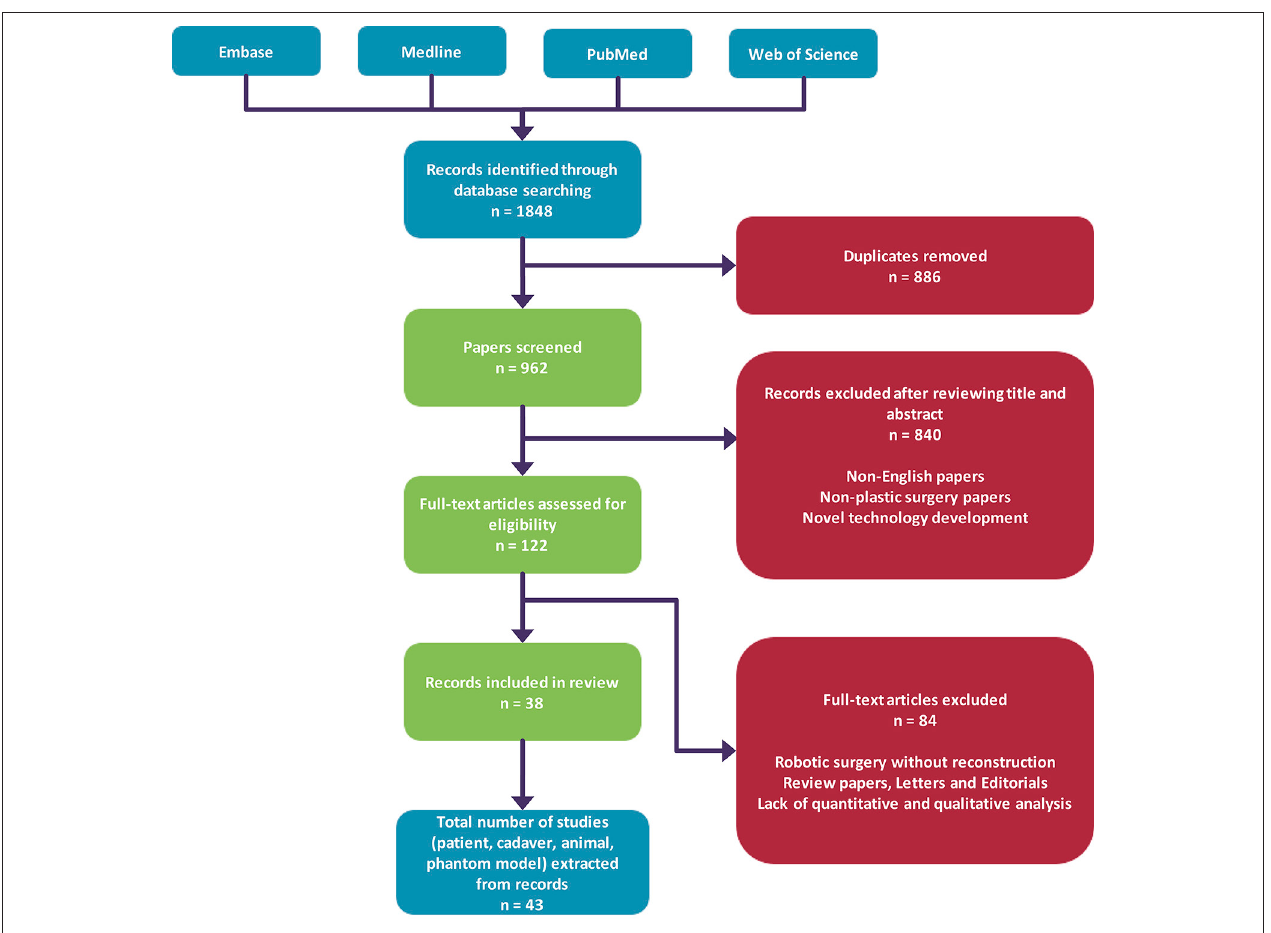
FiguRe 2 | Flowchart of the database search strategy used in this